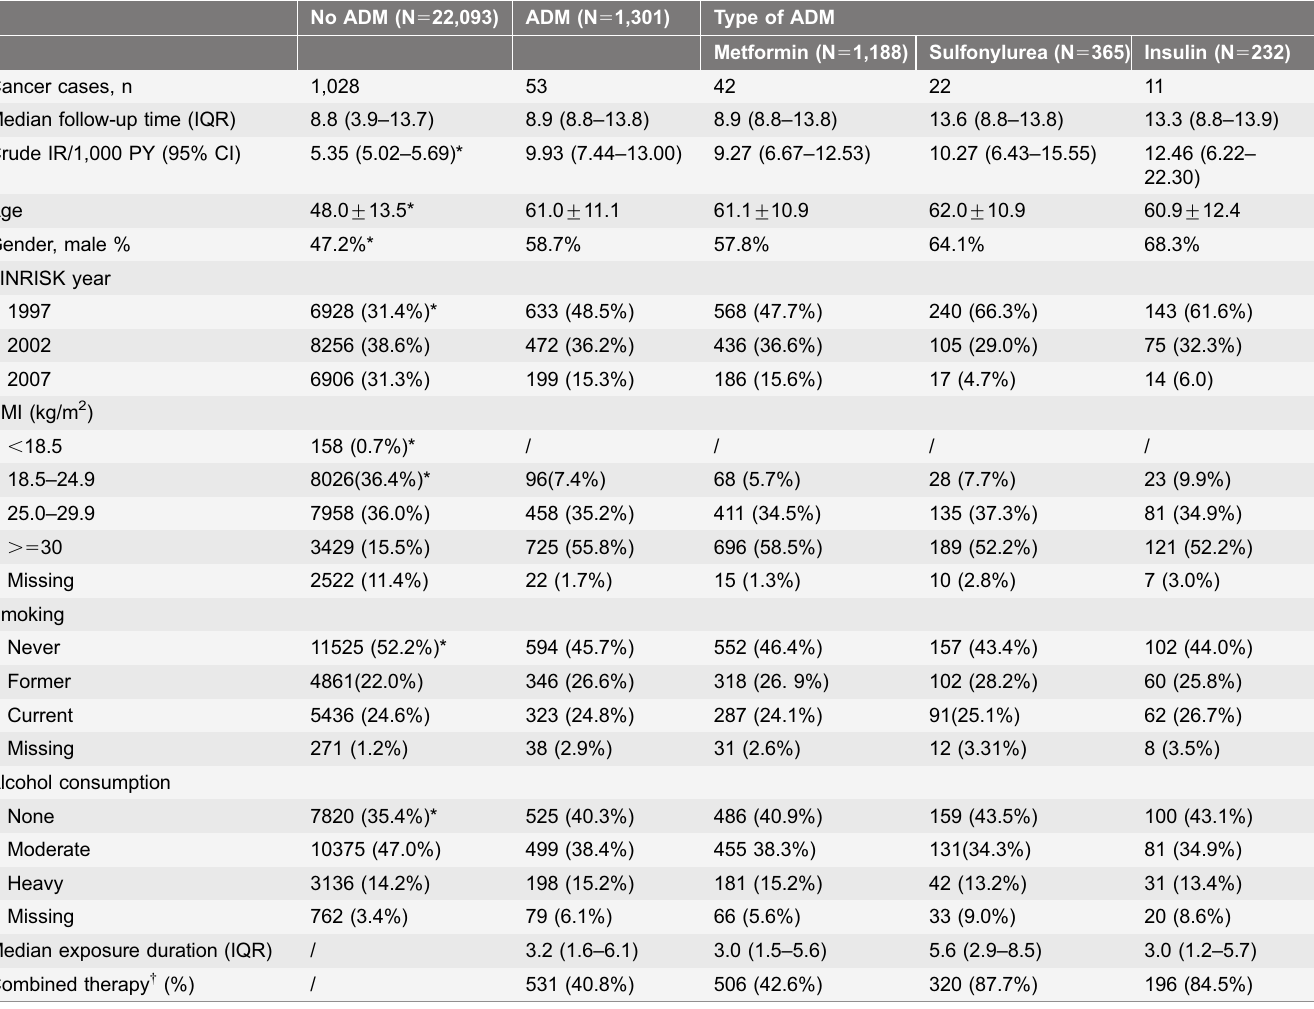
Table 1. Baseline and exposure characteristics among non-users and those who started ADM during the study period,